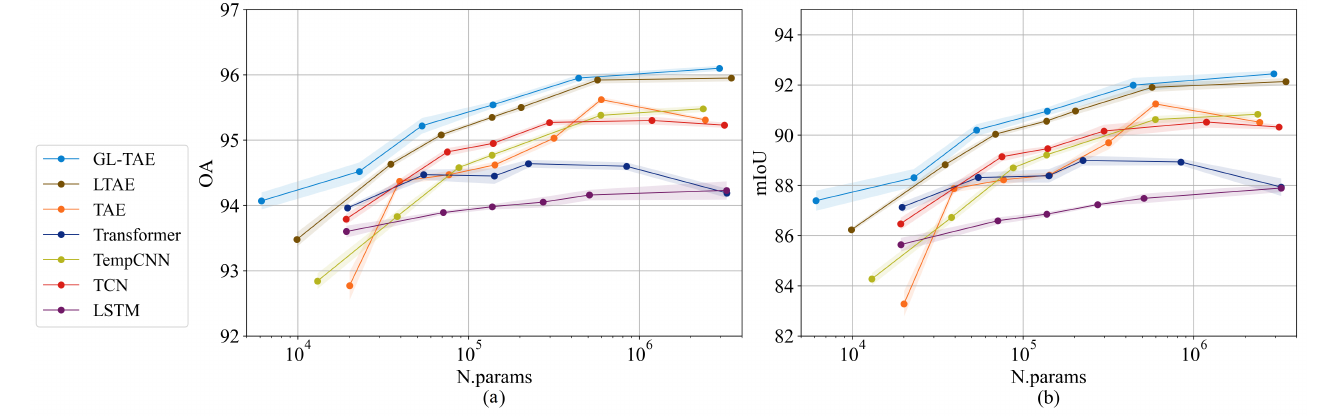
Figure 5. Performances of ( a ) OA and ( b ) mIoU on TimeSen2Crop of the different methods plotted with respect to the parameter